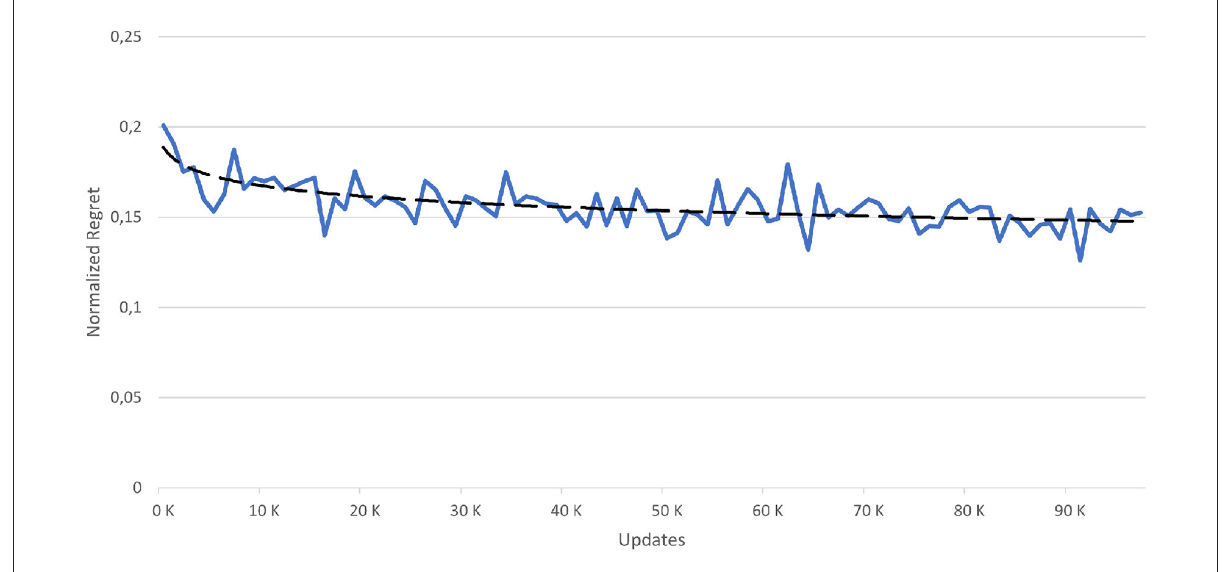
FIGURE7 Regret for the reinforcement learning